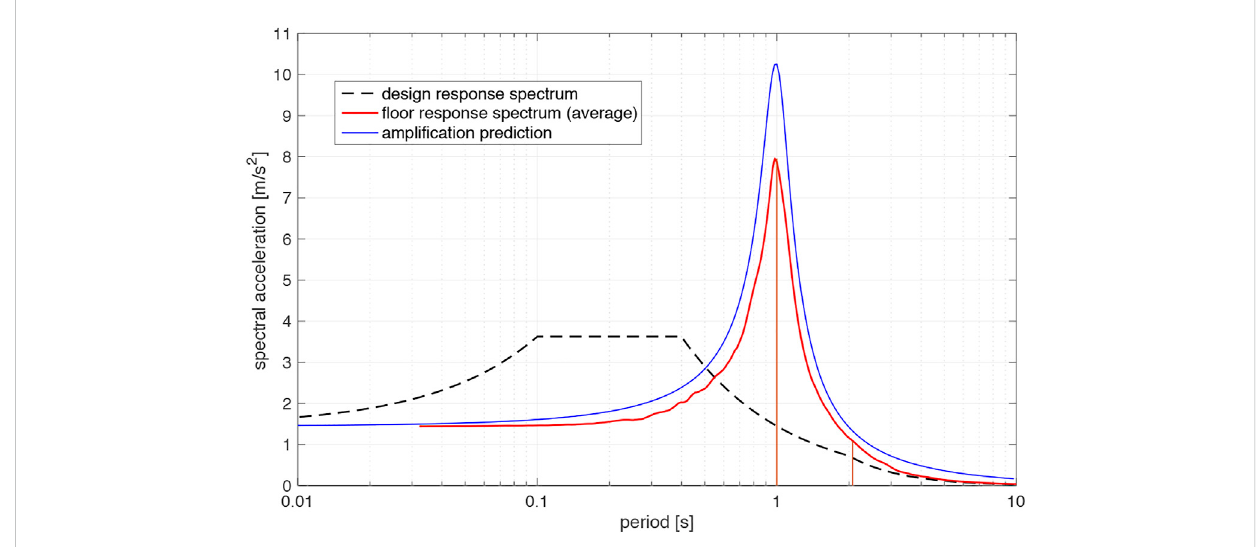
FIGURE 13 Floor response spectra, comparison of the obtained average response spectrum and the ampli fi cation prediction according to Eq. 5.